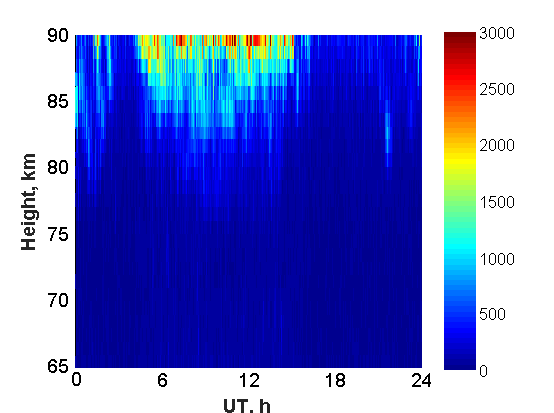
Fig. 9. The standard deviation of the measurement data of electron